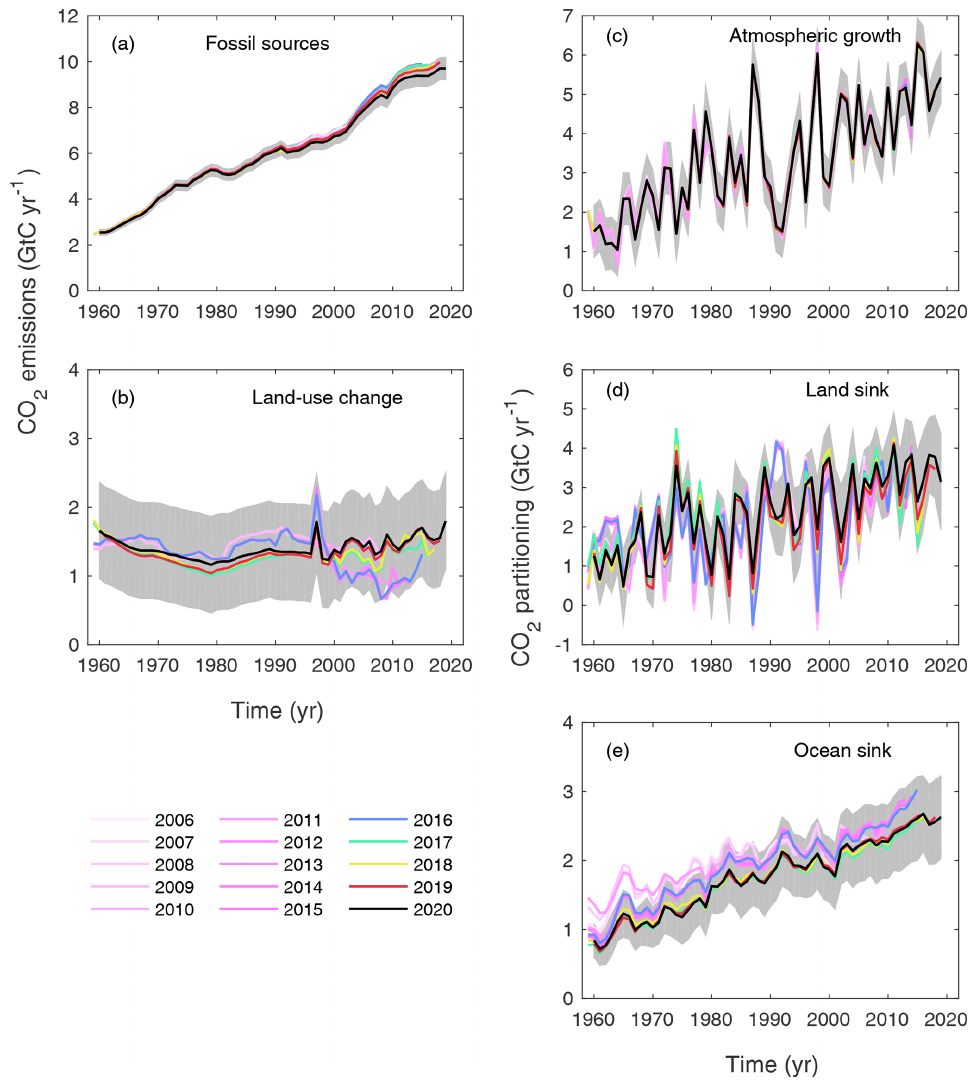
Figure B4. Comparison of global carbon budget components released annually by GCP since 2006. CO 2 emissions from (a) fossil CO 2 emissions ( E FOS ) and (b) land-use change ( E LUC ), as well as their partitioning among (c) the atmosphere ( G ATM ), (d) the land ( S LAND ), and (e) the ocean ( S OCEAN ). See legend for the corresponding years, and Tables 3 and A7 for references. The budget year corresponds to the year when the budget was first released. All values are in GtCyr − 1 . Grey shading shows the uncertainty bounds representing ± 1 σ of the current global carbon budget. Note that the 2020 estimate of E FOS includes the cement carbonation